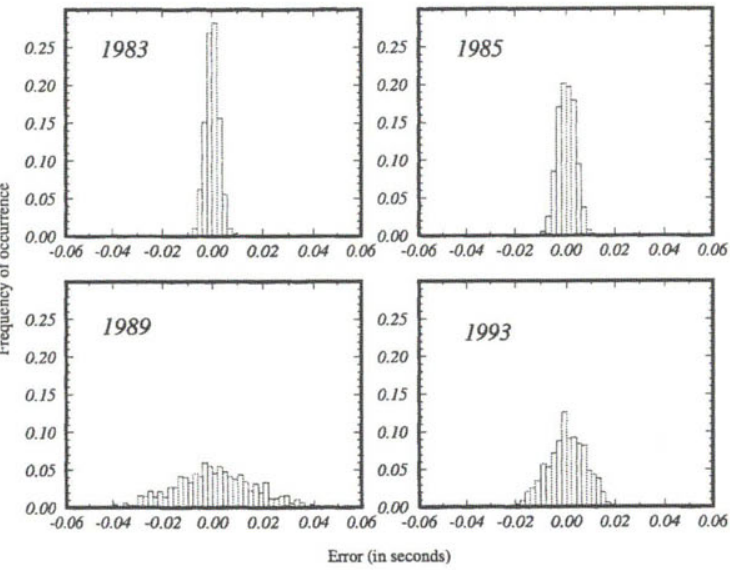
Fig. 1. Error distributions obtained from Monte Carlo simulations for estimates of the period of 516 s of PG1159-035 (number of simulations: